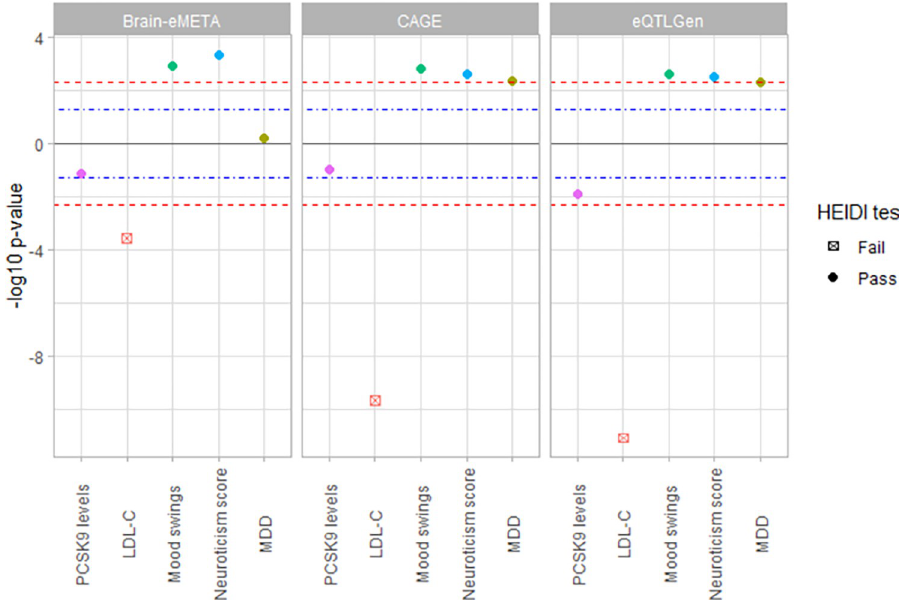
Fig 3. MR association of USP24 gene-expression levels with phenotypes of interest in replication cohorts. The y- axis represents the -log 10 p-value of the MR association, while the direction signifies the direction of effect of gene- expression reduction, which serves as a proxy to the corresponding drug effect. SMR multi-SNP analyses associations for CAGE consortium (peripheral blood), eQTLGen consortium (whole blood), and Brain-eMETA dataset (brain) for USP24 gene-expression. The blue and red lines signify p-value of 0.05 and Bonferroni-corrected threshold for 5 traits per gene of 0.005.